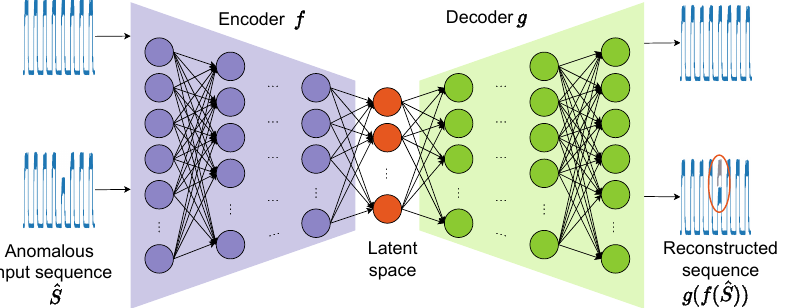
Figure 1. Visualization of a dense autoencoder model for time series anomaly detection, producing a high reconstruction error ∆ ( S , g ( f ( ˜ S )) when presented with the anomalous subsequence ˜ S . Dense refers to the encoder and decoder networks being fully